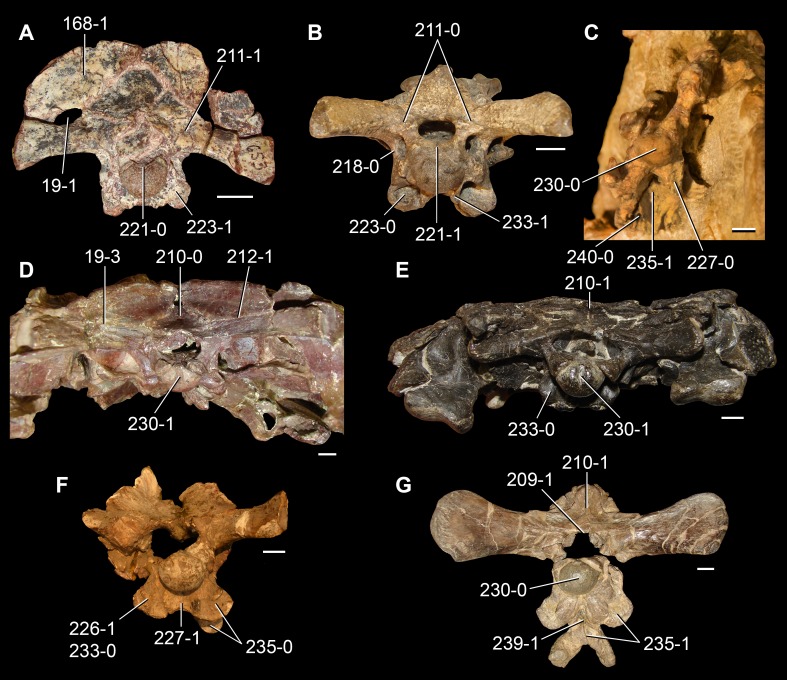
Braincases of Triassic archosauromorphs in occipital view.(A) Azendohsaurus madagaskarensis (UA 7-20-99653); (B) Proterosuchus goweri (NMQR 880); (C) Euparkeria capensis (UMZC T692); (D) Chanaresuchus bonapartei (MCZ 4037); (E) Doswellia kaltenbachi (USNM 214823); (F) Parasuchus hislopi (ISI R42); and (G) Batrachotomus kupferzellensis (SMNS 80260). Numbers indicate character-states scored in the data matrix. Scale bars equal 1 cm in (A, B, F, G), 2 mm in (C), and 5 mm in (D, E).